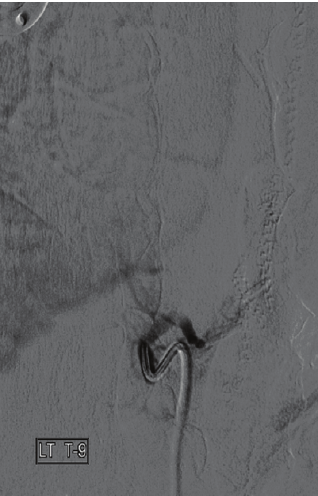
Figure 3: Left T9 intercostal artery immediately after TACE with irinotecan-eluting beads. Note that there is a small branch o ff of the T9 intercostal artery which still seems to supply the tumor, indicating the need to repeat the procedure in two weeks to completely chemoembolize the branch with irinotecan-eluting beads.